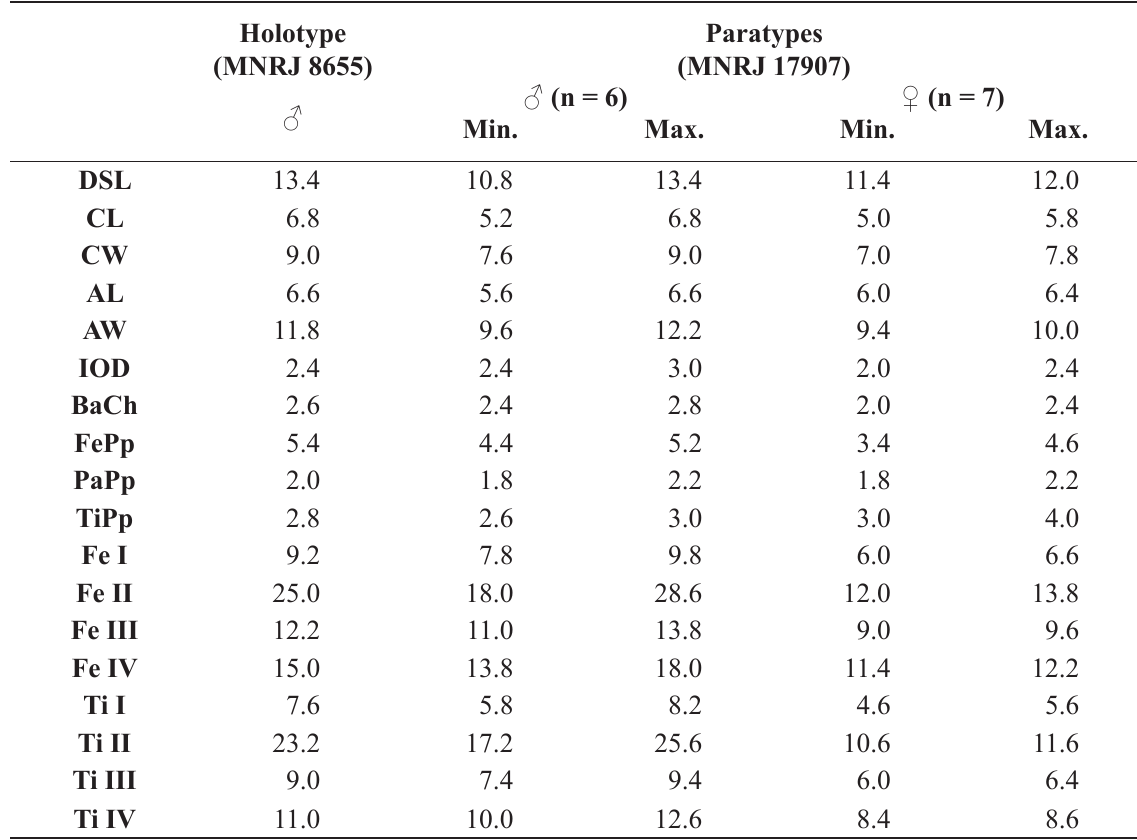
Table 5. Phalangodus gyes sp. nov., measurements of body and appendage, in